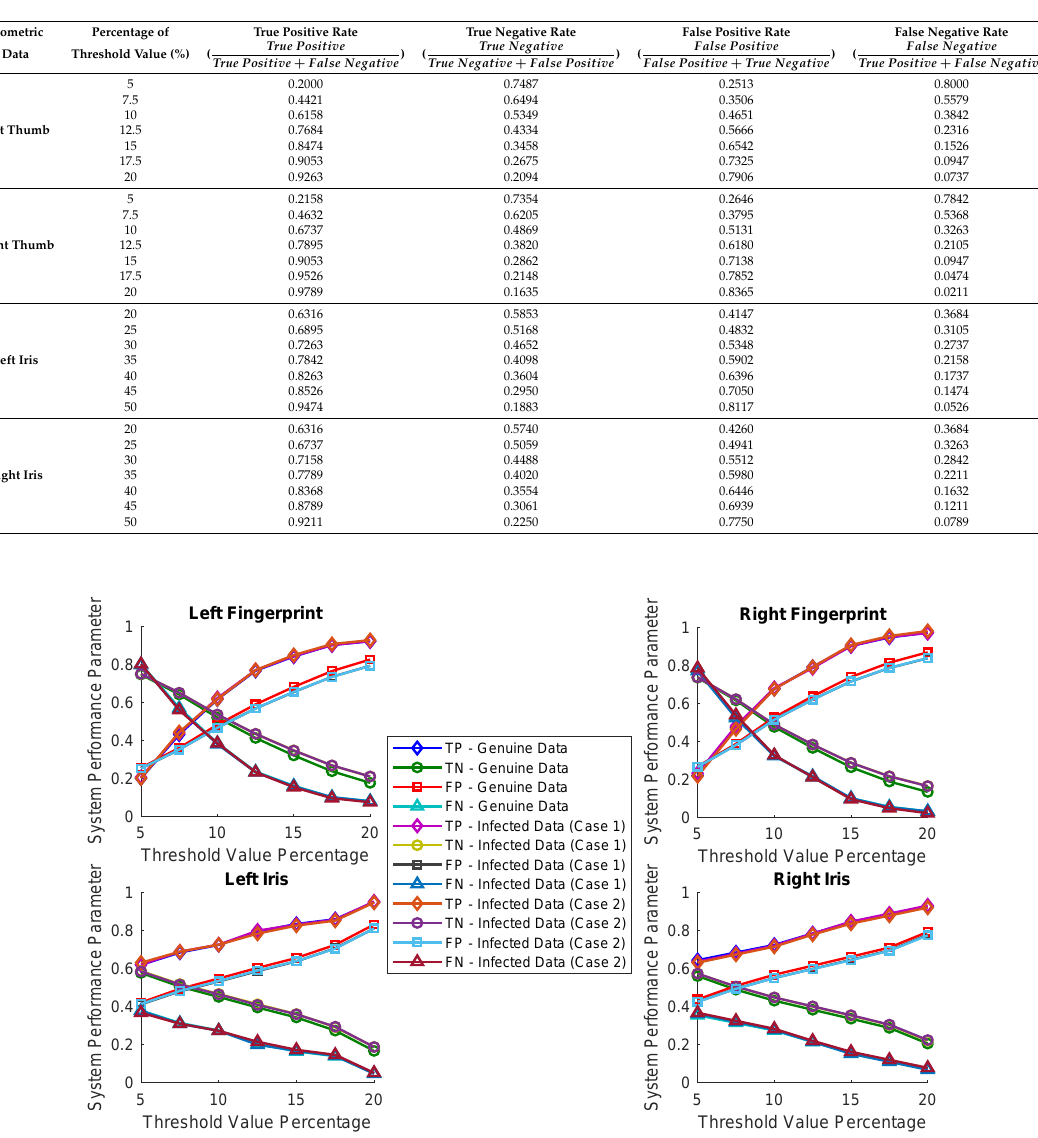
Table 4. Performance Evaluation Results (3): The performance evaluation of the infected cross-layer biometric recognition system for four biometric datasets.